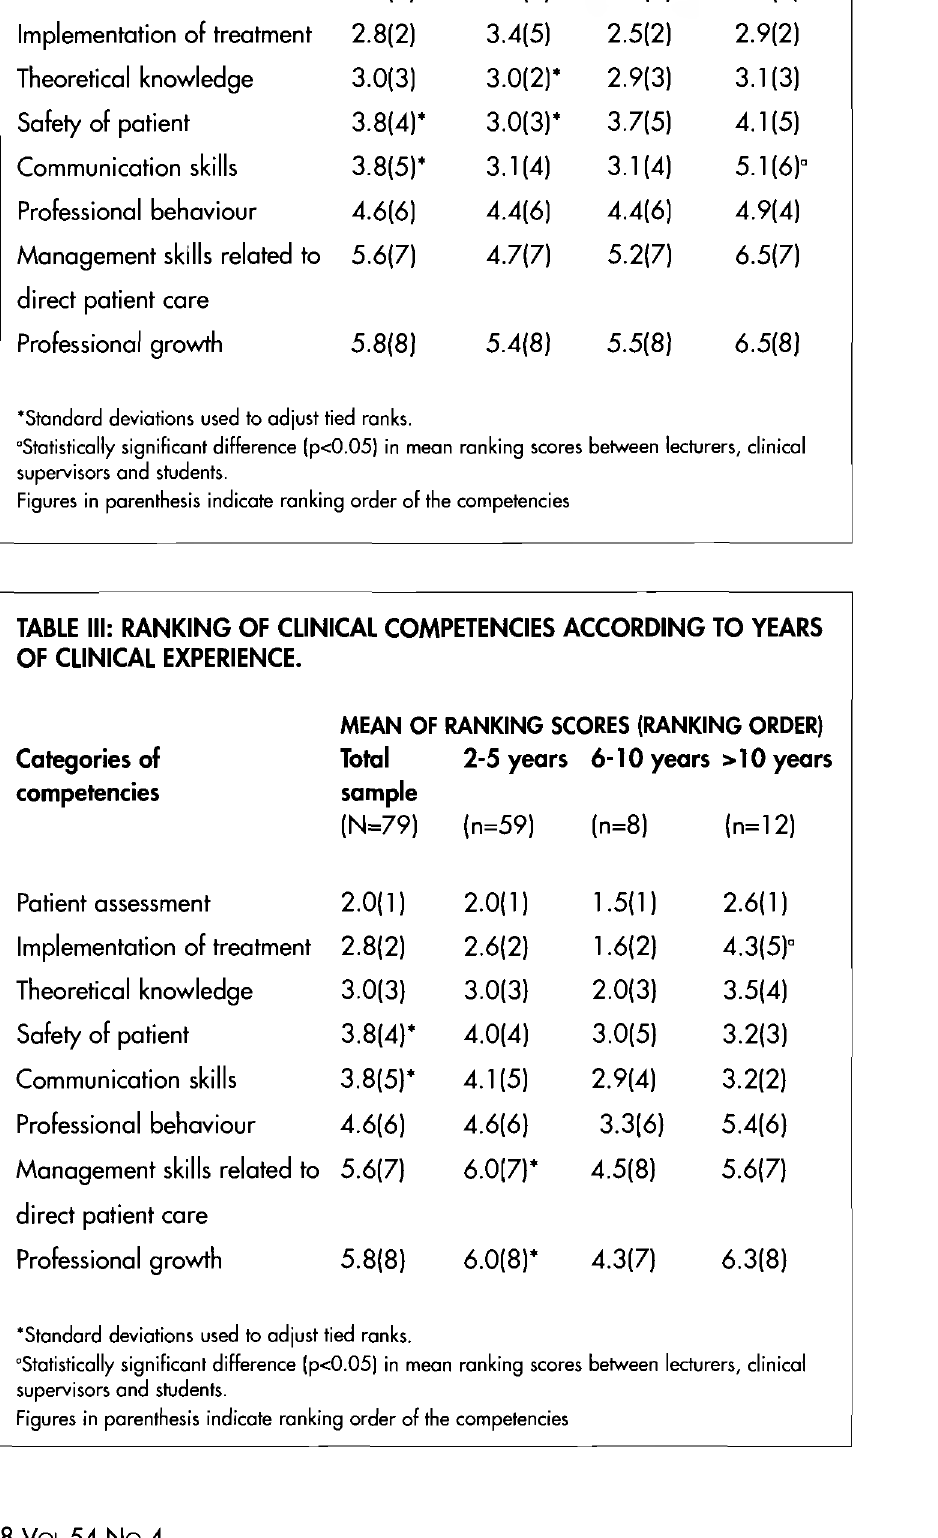
TABLE II: RANKING OF CLINICAL COMPETENCIES BY LECTURERS, CLINICAL SUPERVISORS AND